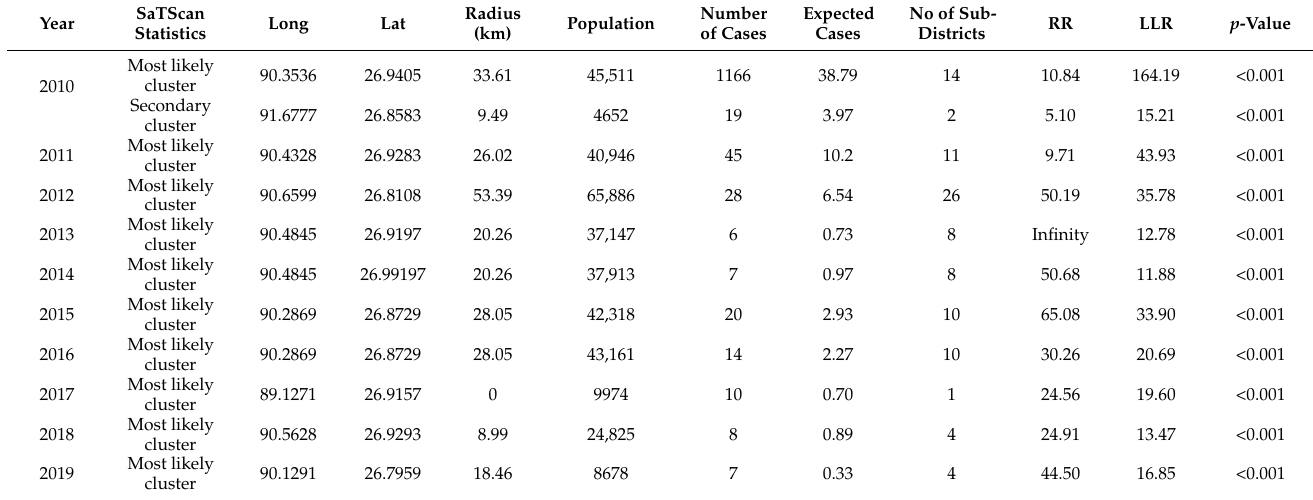
Table 3. Spatial clusters of Plasmodium vivax at sub-district level in Bhutan, 2006–2019.